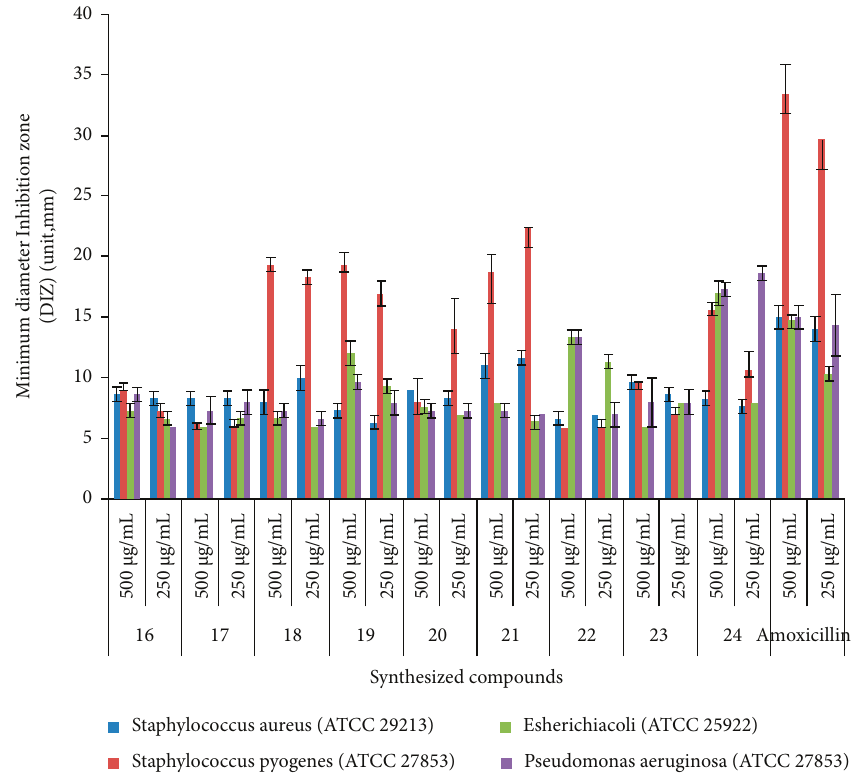
Figure 2: Minimum diameter inhibition zone of the synthetic compounds (16-24) in mm (mean ± SD) at 250 and 500 μ g/mL